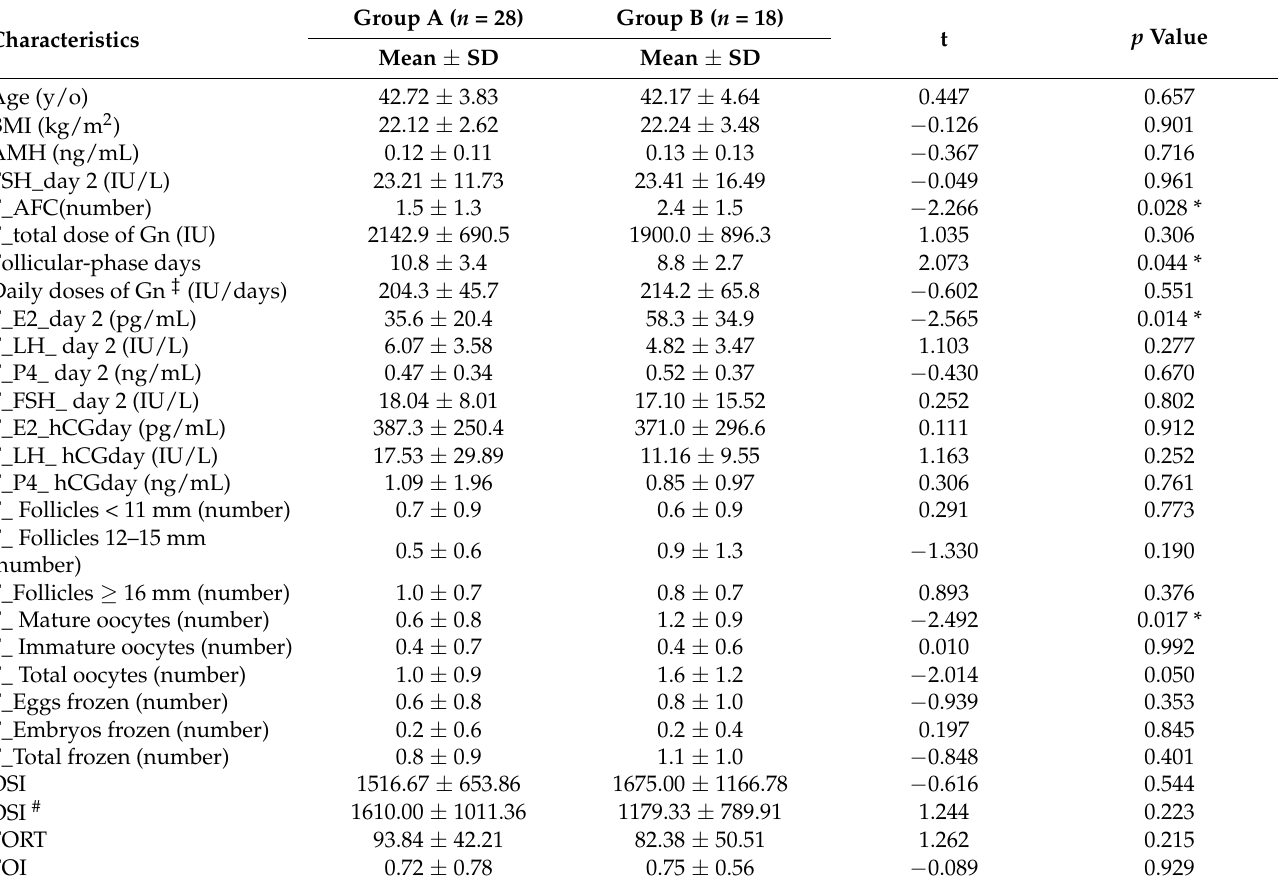
Table 1. The demographic characteristics and clinical response of the subjects.